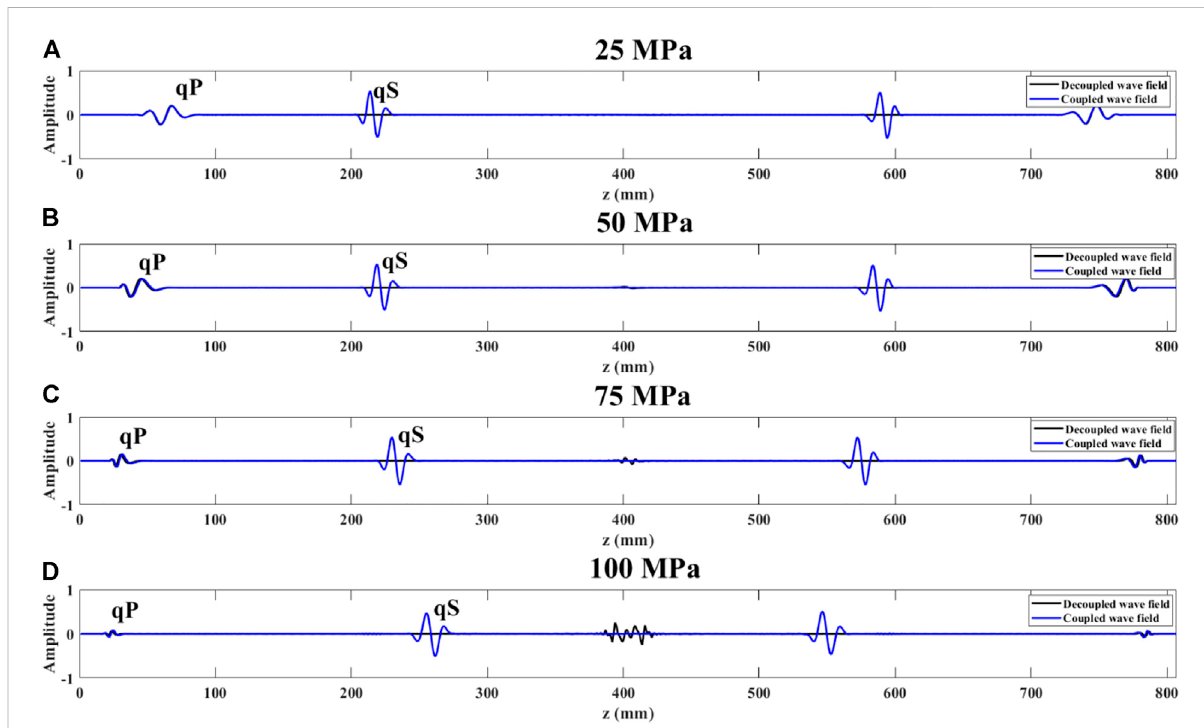
FIGURE 13 Records of x =320 mminsnapshots abovefor variouspureshear stresses ( (A) :25 MPa; (B) : 50MPa; (C) :75MPa; (D) :100 MPa). (The black solid lines indicate records of decoupled wave fi eld; the blue solid lines denote records of coupled wave fi eld).